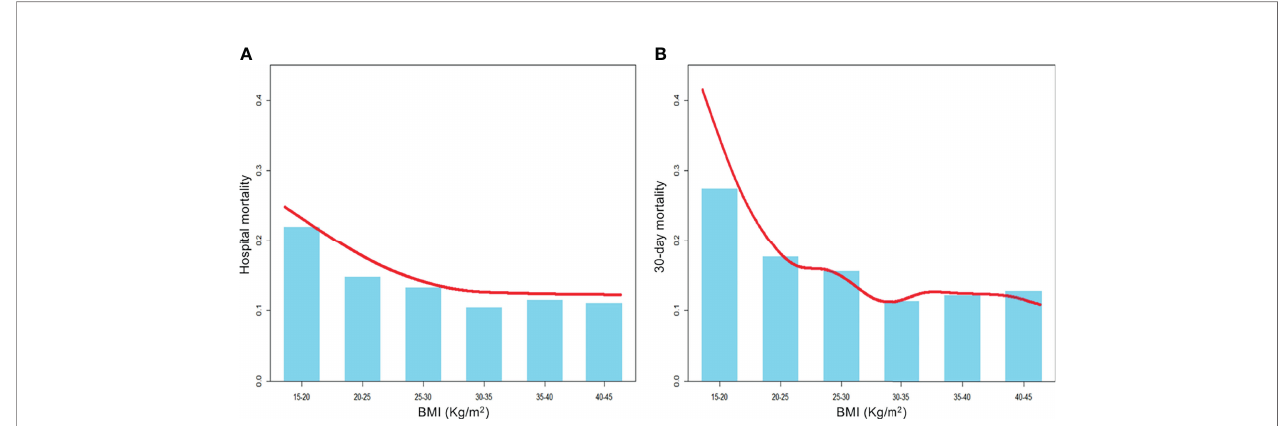
FIGURE 2 | A smooth curve fi tting for the relationship between BMI and the risk of hospital (A) and 30-day (B) mortality. It is observed that BMI was negatively correlated with short-term mortality before any